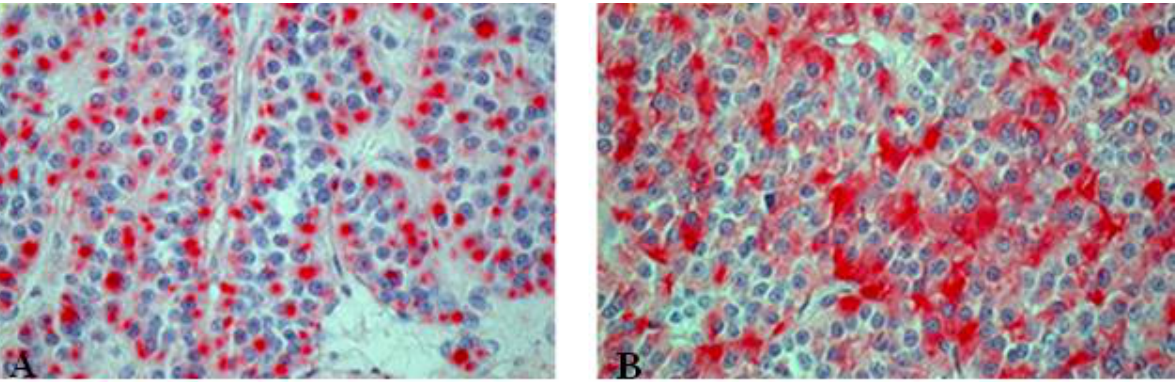
Figure 8. Immunohistochemical staining of atypical carcinoid tumor with ( A ) punctual positive KL1 reaction and ( B ) chromogranin